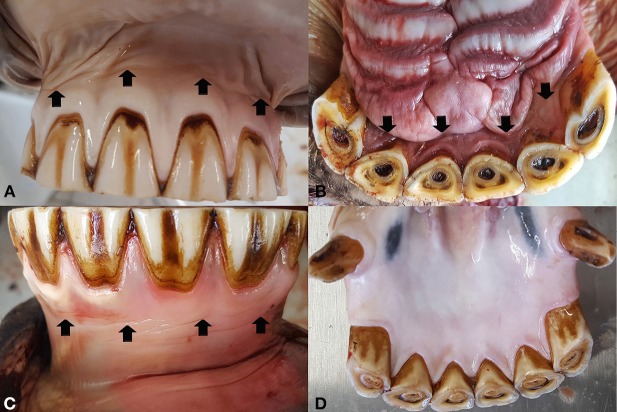
The mucogingival junction (arrows) of the incisors is clearly visible in the labial (A) and palatal (B) aspect of the upper incisors as well as in the labial aspect of the lower incisors (C). In the lingual aspect of the lower incisors (D) the gingival fuses with the oral mucosa without a pronounced mucogingival junction.